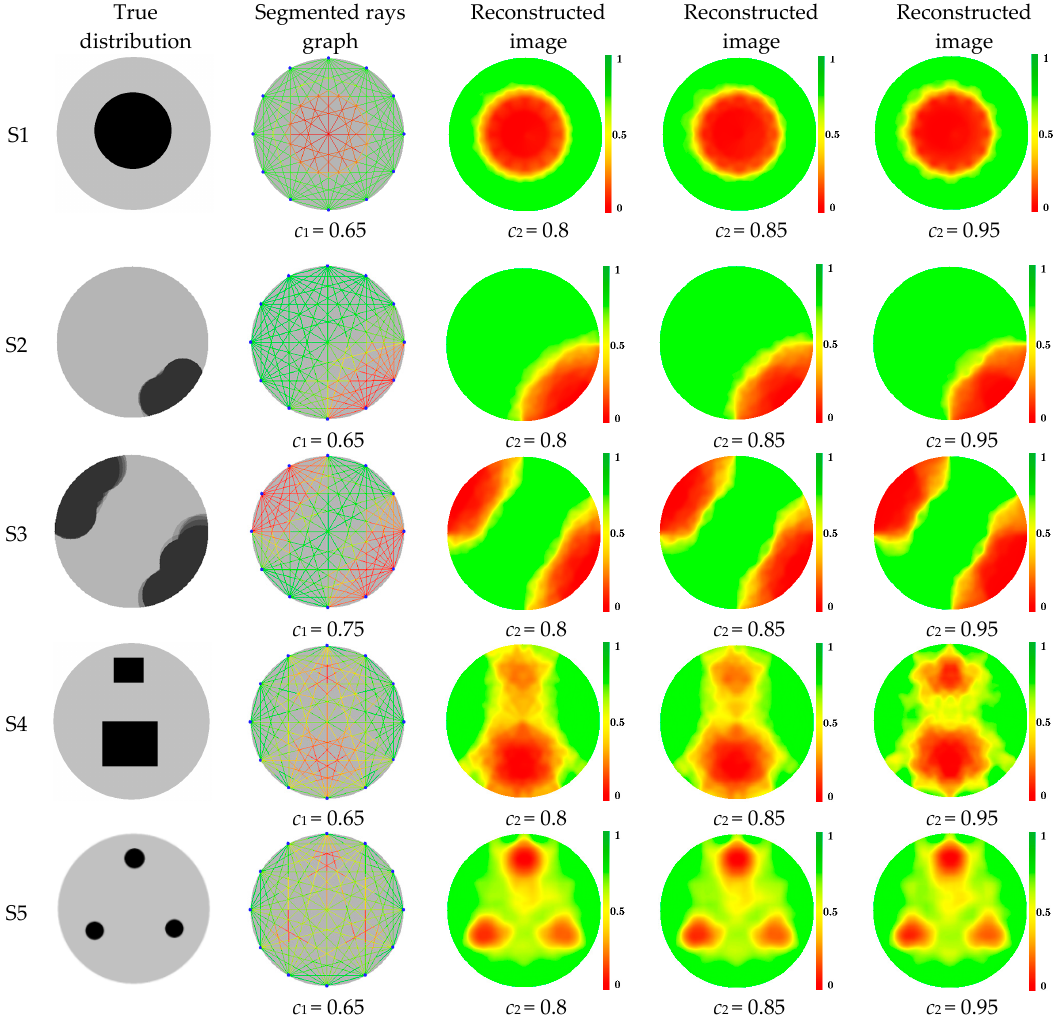
Figure 7. Images reconstructed using the SISE method from simulation data with different control coefficients.